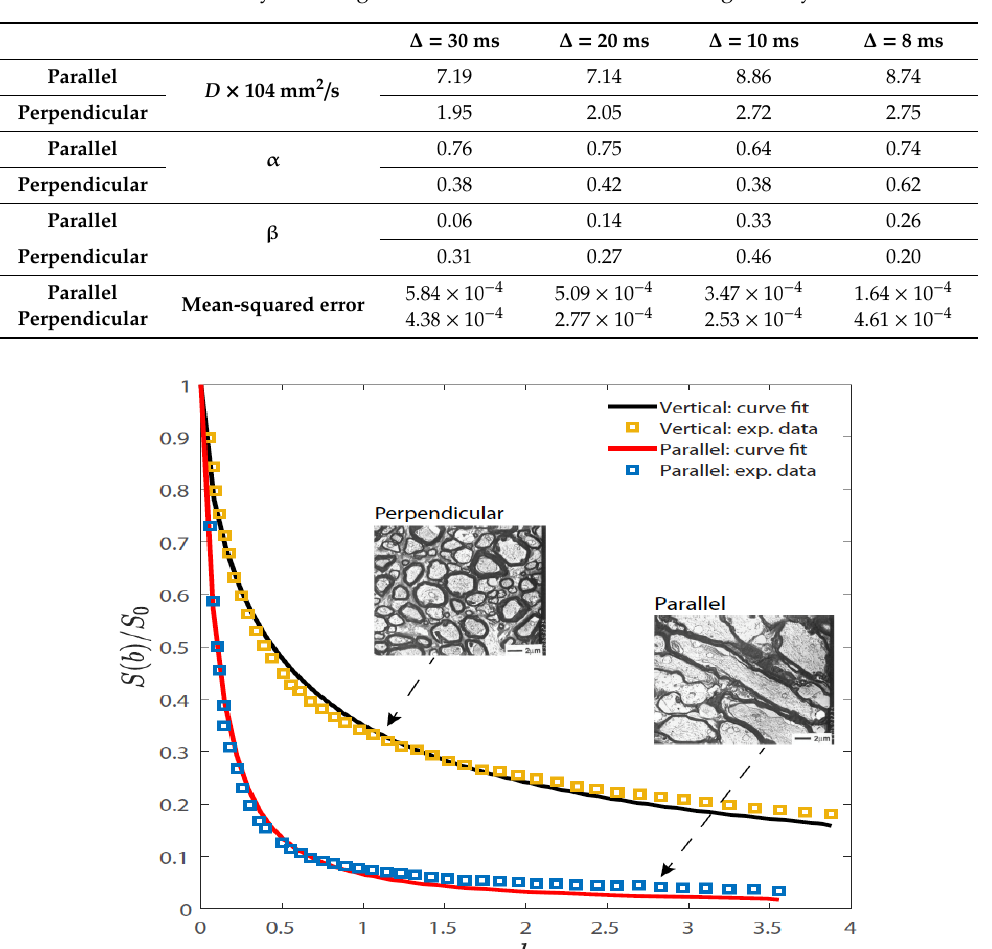
Figure 8. An example of the normalized stretched Kilbas-Saigo signal decay fits of S(b) / S 0 to the bovine optic nerve data for the parallel and perpendicular directions with ∆ = 30 ms. The photomicrographs are from [35] and are used with permission from the journal Magnetic Resonance in Medicine.